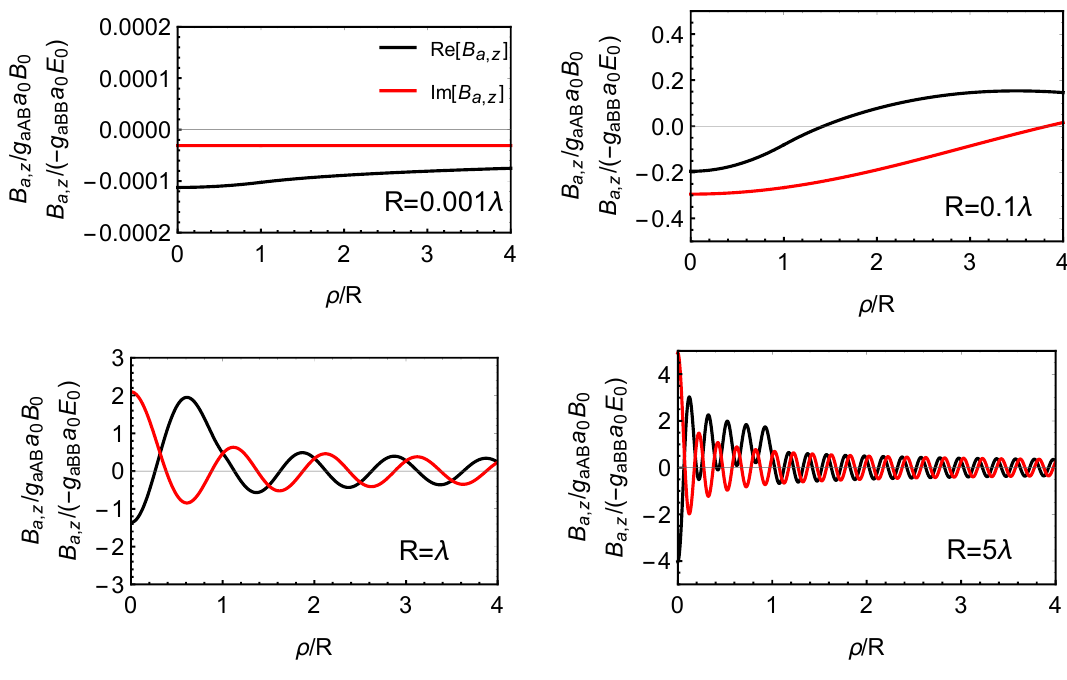
Figure 3 . Numerical results of axion-induced oscillating magnetic field ~B a,z at t = 0 , in units of g aAB a 0 B 0 for case I or − g aBB a 0 E 0 for case II, as labeled in figure 2.